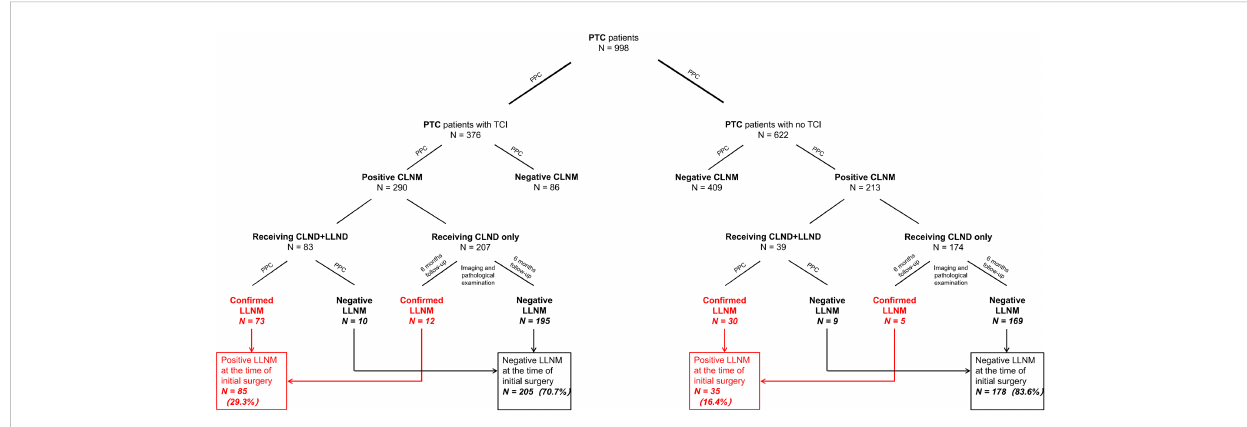
FIGURE 1 Flow diagram of case selection steps and follow-up information for patients enrolled. PTC, papillary thyroid carcinoma; PPC, postoperative pathology con fi rmed metastasis; CLNM, central lymph node metastasis; LLNM, lateral lymph node metastasis; CLND, central lymph node dissection; LLND, lateral lymph node